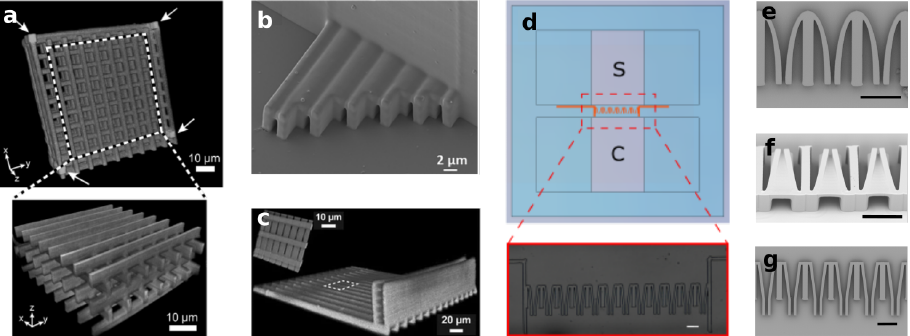
Figure 5. Examples of polymeric structures for cell migration assays realized with TPP: ( a ) Confocal image of woodpile structure, integrated inside a microfluidic channel (the microchannel extends along x axis) (Reprinted with permission from Ref. [73]. Copyright 2013, The Royal Society of Chemistry); ( b , c ) Arrays of straight microchannels realized inside a glass and plastic microchannels (Reprinted with permission from Ref. [70], Copyright 2019 American Chemical Society and from Ref. [93], Copy- right 2015 Springer Science+Business Media New York); ( d ) Example of glass–polymer microfluidic cell migration assay, completely realized with femtosecond laser micromachining (scalebar 100 µm); SEM images of different possible micro-constriction geometries, realized with TPP, with ( e ) Elliptical profile, ( f ) Three-dimensional profile and ( g ) Combination of funnel profile and straight channels (scalebar 100 µm, Reprinted with permission from Ref. [74]. Copyright 2021, Sala et